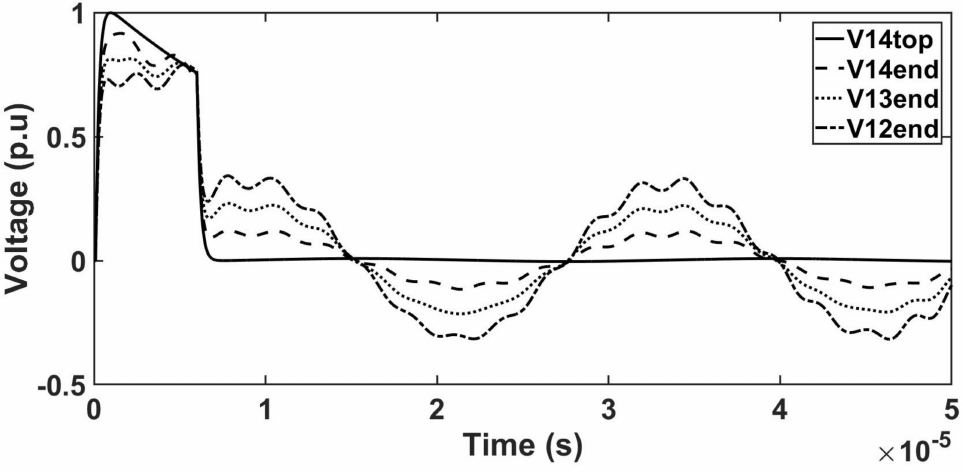
Figure 20. Surge voltage waveforms for unshielded winding under